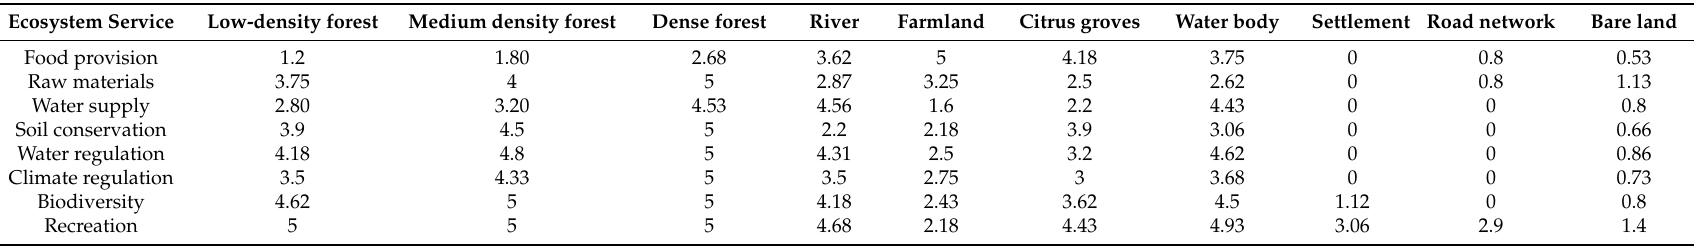
Table 3. Ecosystem services scored for different land use classes based on expert judgment. Scores were rated on a scale from 0–5 where 0 represented no service and 5 the maximum potential